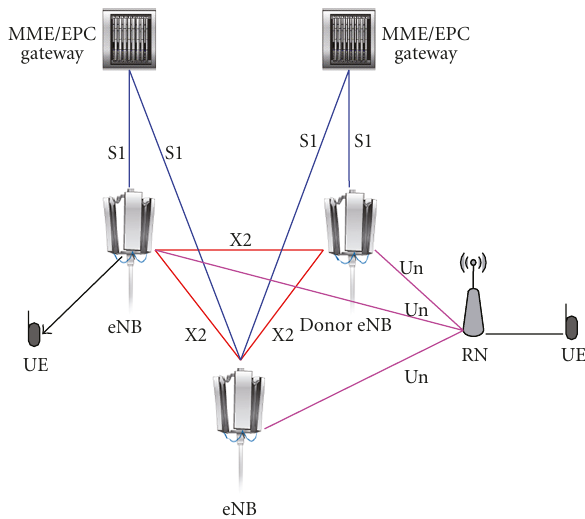
Figure 7: Architecture for enabling distributed relaying in